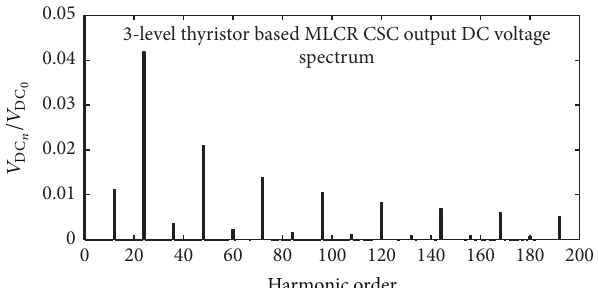
Figure 4: Harmonic spectrum of 𝑉 DC of 3-level thyristor based MLCR CSC for 𝛼 = − 45 ∘ .